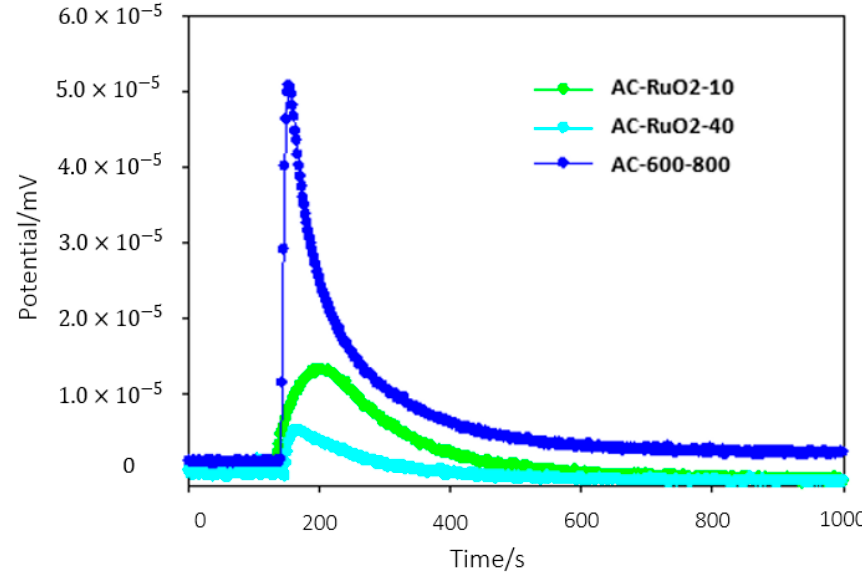
Figure 2. Potentiogram obtained for the immersion of solids in water.